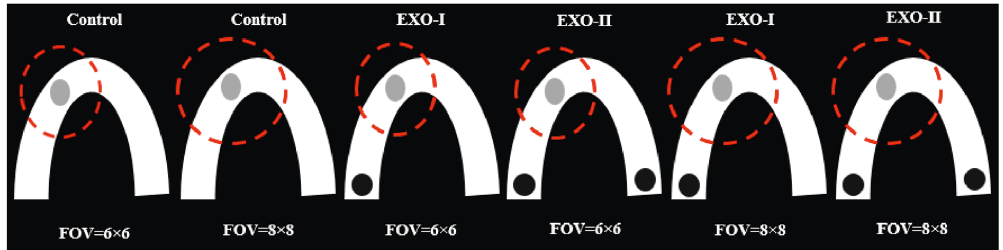
Figure 2: Schematic view of the mandible and position of metal objects relative to the polypropylene tube. Exo: exomass, FOV, the field of